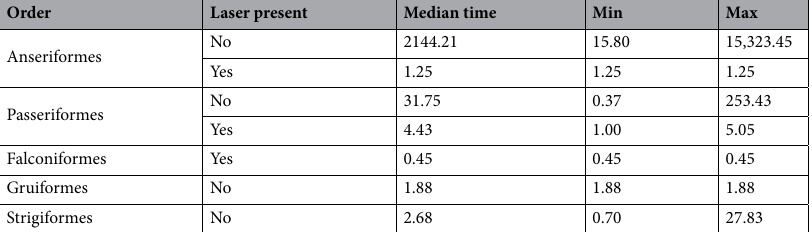
Table 4. Summary of daily exposure time (in min.) of free-range study area to wild birds. This is a combination of the number of birds visiting daily and the duration of their visit during the experimental periods (28 observation days with and 29 days without the laser in operation), grouped by taxonomic Order.